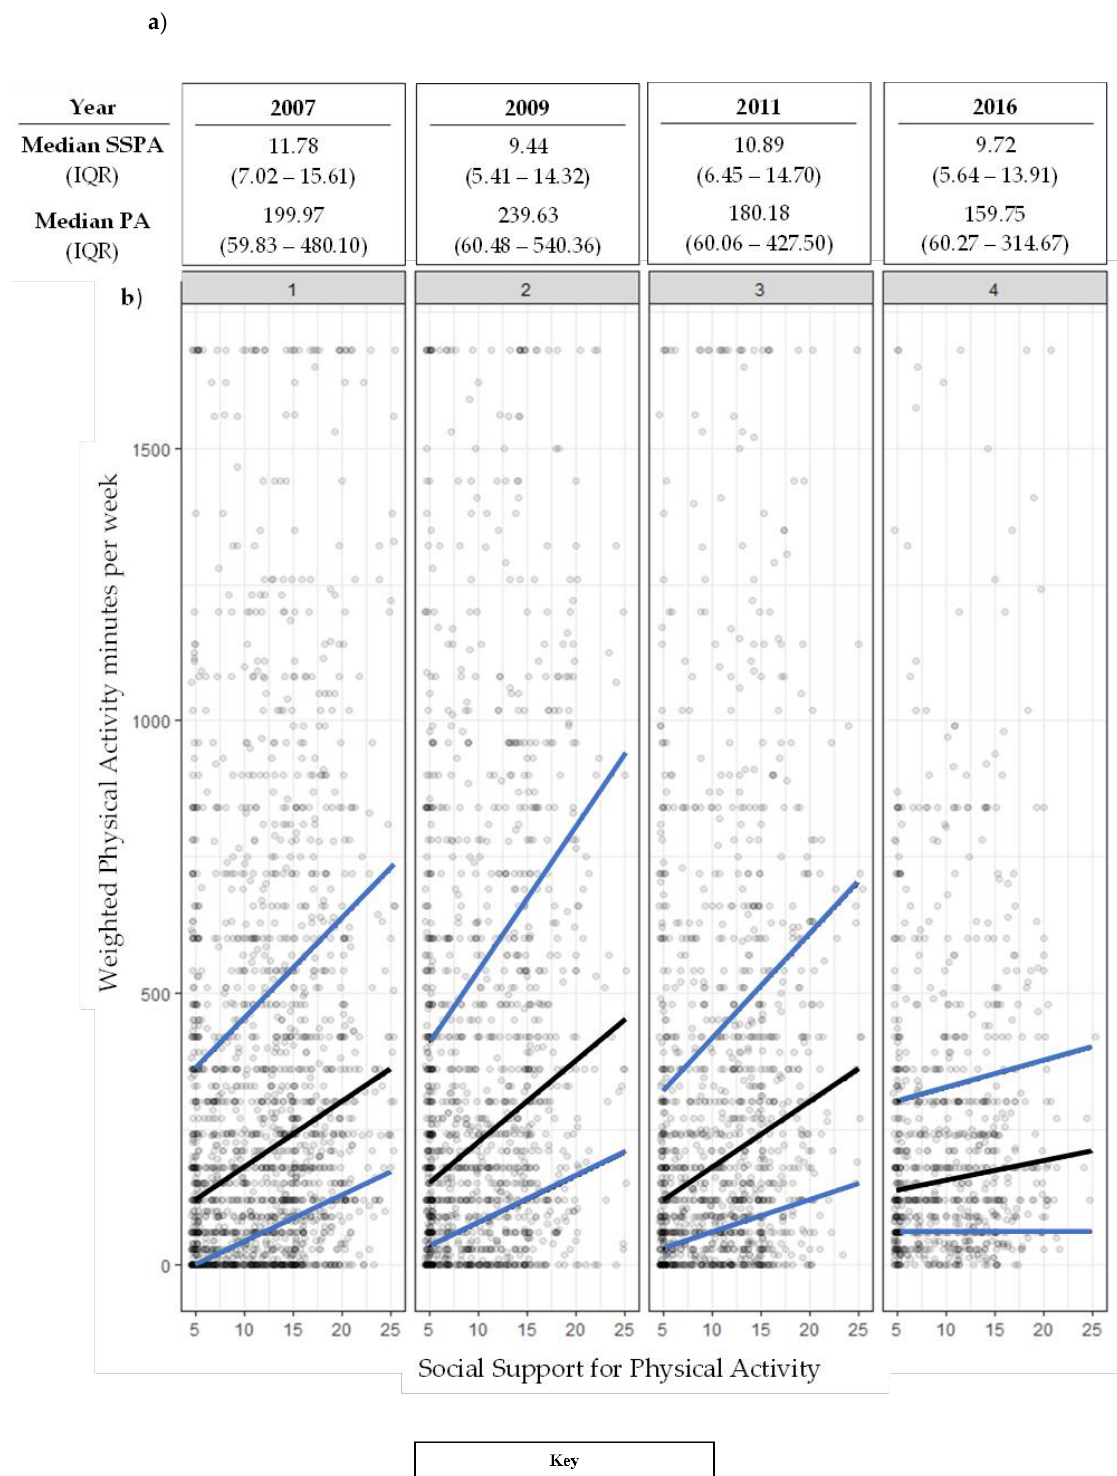
Figure 2. Relationship between social support for physical activity (SSPA) and physical activity (PA) at each wave: ( a ) overall median (IQR); ( b ) scatterplot of SSPA and PA scores.